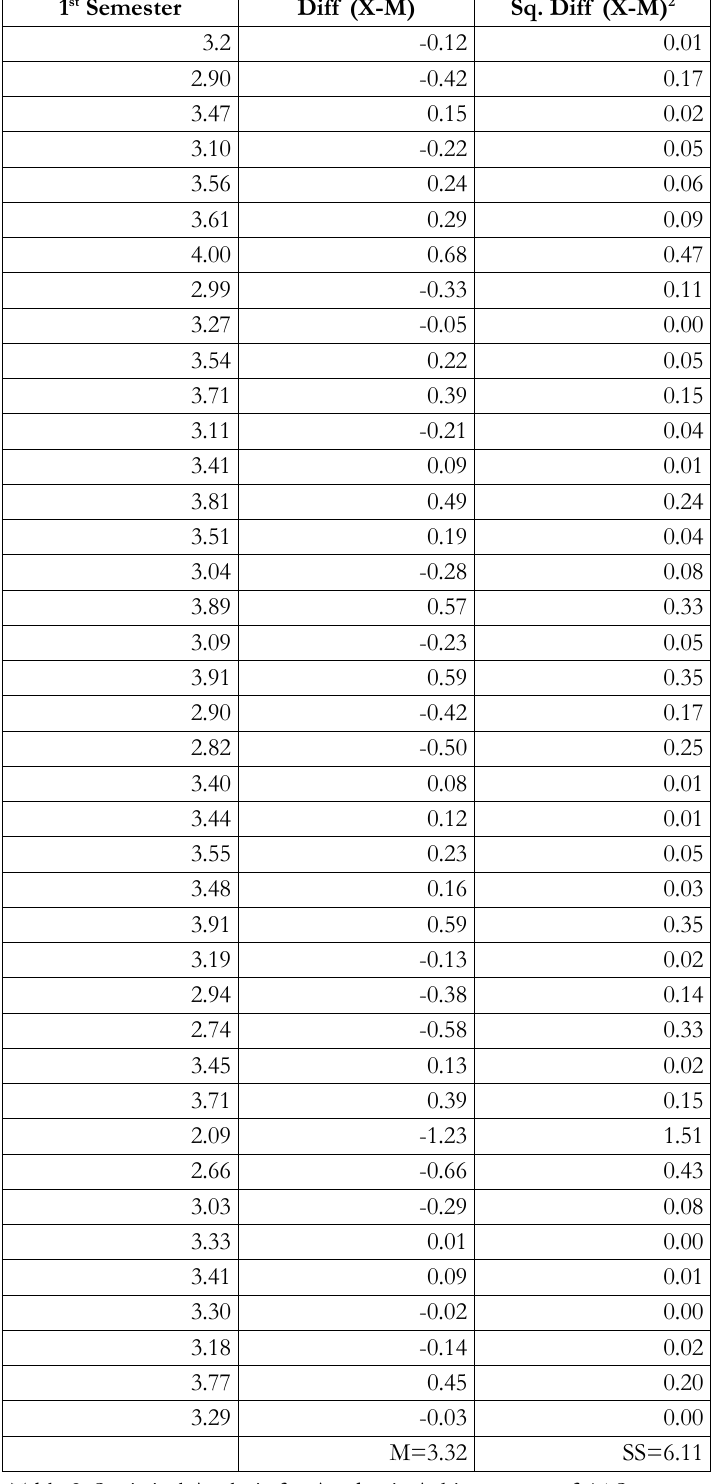
Table 2. Statistical Analysis for Academic Achievements of 1 st